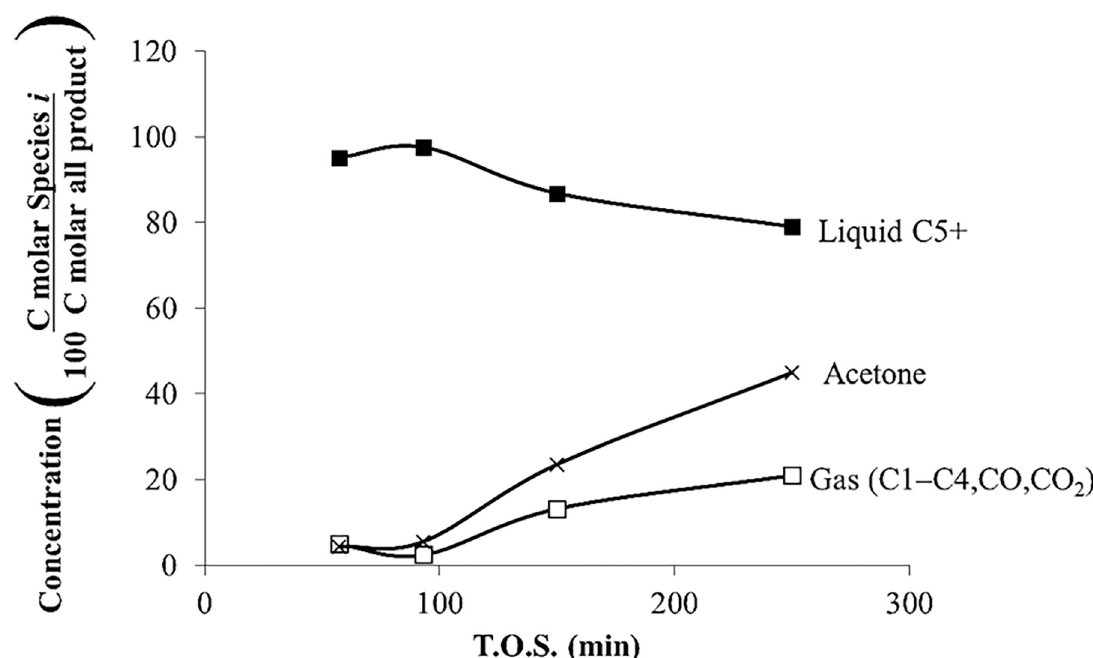
Fig 5. Product distribution of gases and liquids for the acetone reaction over HZSM-5(280), T = 415˚C, WHSV = 9.48 h –1 , P = 790 kPa (abs).